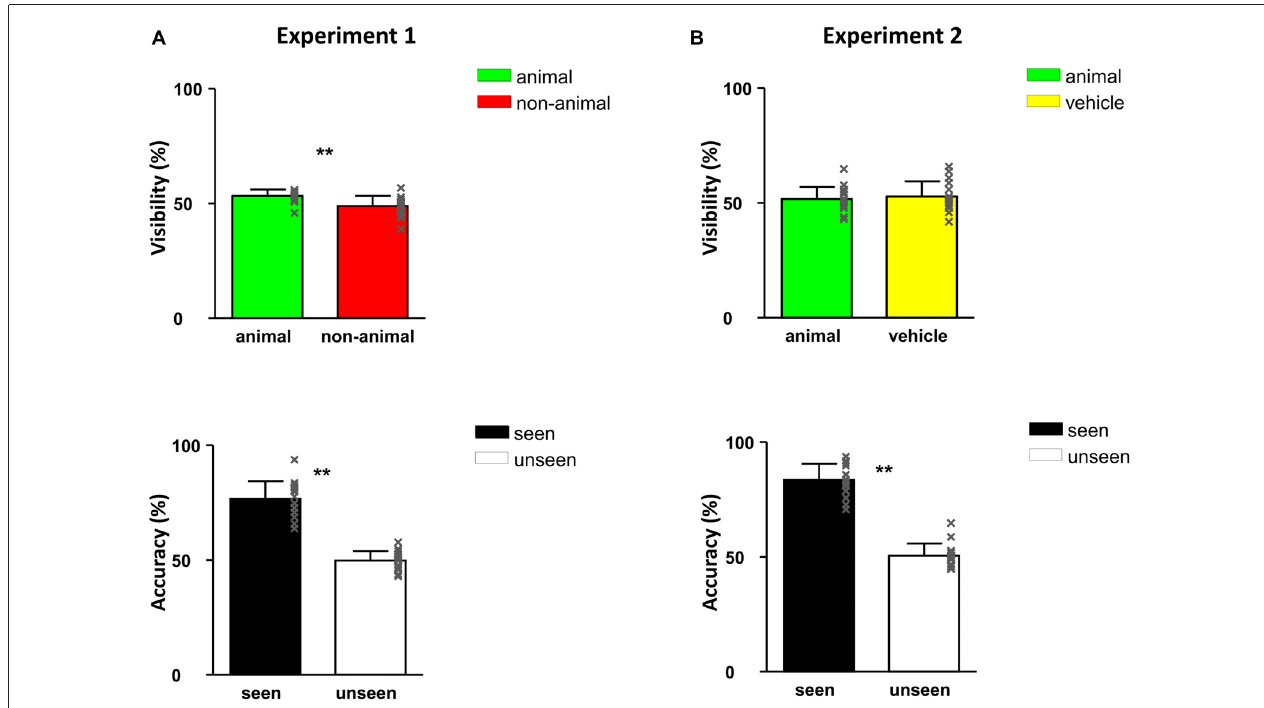
FIGURE 3 | Responses of Experiment 1 (A) and Experiment 2 (B): visibility (top) and accuracy (bottom). All error bars represent 1 SEM. The x-shaped markers represent individual subjects. Asterisk markers designate statistical significance: ∗ p < 0.05, ∗∗ p <